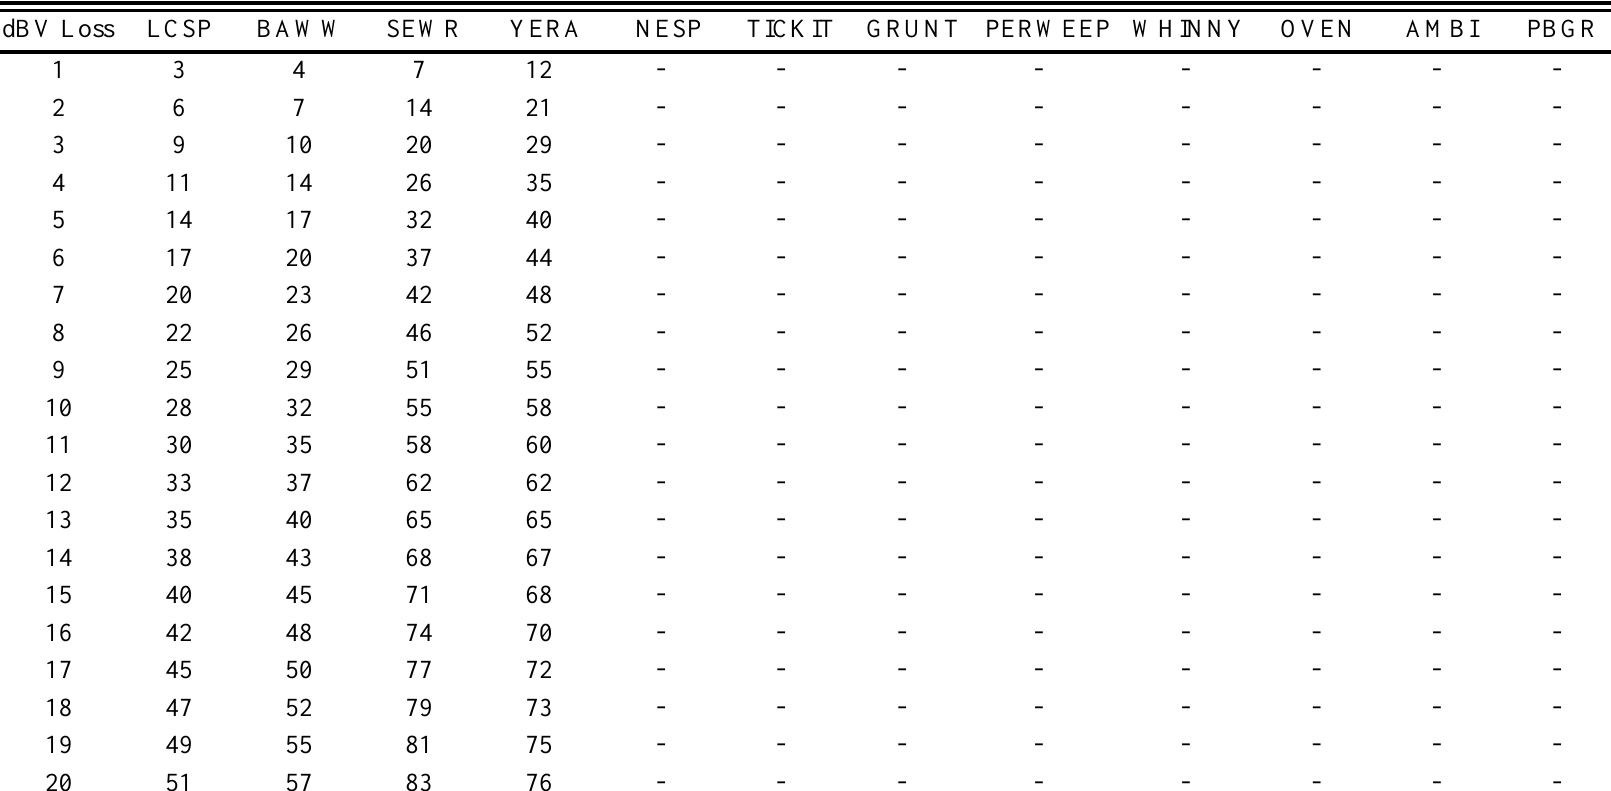
Table A5.4. Percent effective detection area loss of the four call types that did not exceed our experimental range and for varying degrees of microphone sensitivity loss under ambient noise conditions (32